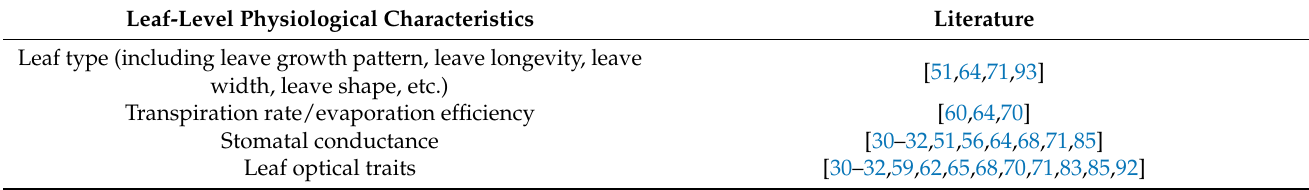
Table 4. Leaf-level physiological characteristics summarized in the literature. Leaf-Level Physiological Characteristics Leaf type (including leave growth pattern, leave longevity, leave width, leave shape, etc.)